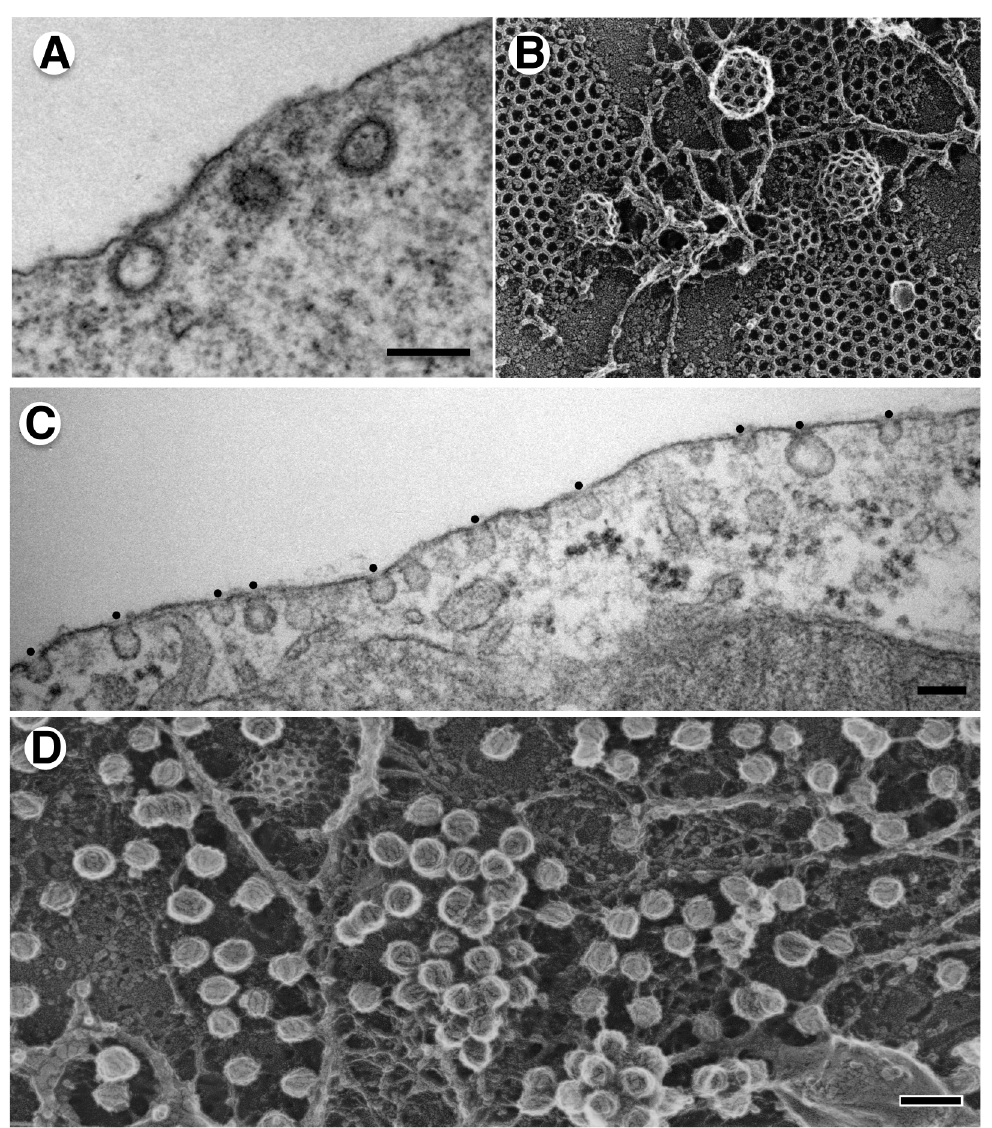
Figure 1. Thin section and quick-freeze deep etch images of clathrin coated vesicles and caveolae. (A) Thin section, TEMs reveal the bristled appearance of clathrin-coated pits in fixed and plastic embedded mouse fibroblasts (from [27]), bar=200 nm. (B) Quick-freeze deep-etch images reveal the lattice-like coat on flat and rounded clathrin coated pits, courtesy of John Heuser. (C) Ultra thin section EM of caveolae in fixed and plastic embedded 3T3-L1 adipocytes (from [18]). Bar=100 nm. (D) Deep-etch EM replica of differentiated 3T3-L1 adipocyte produced in the Heuser lab by N. Morone, iCeMS, Kyoto University, Japan. Bar=100 nm.